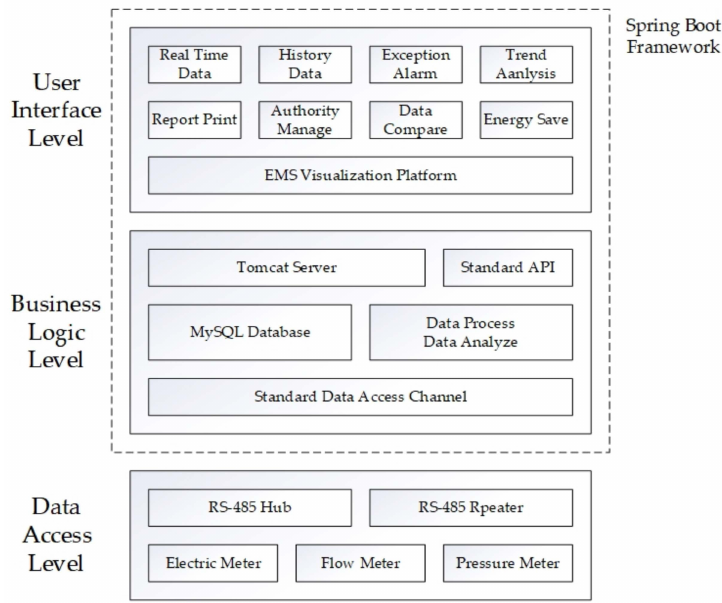
Figure 1. Overall system